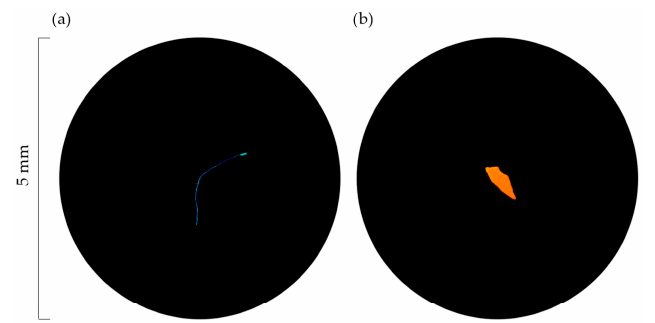
Figure 2. Examples of the types of MPs considered: ( a ) fibre and ( b ) fragment. Image credits: Archipelagos Institute of Marine